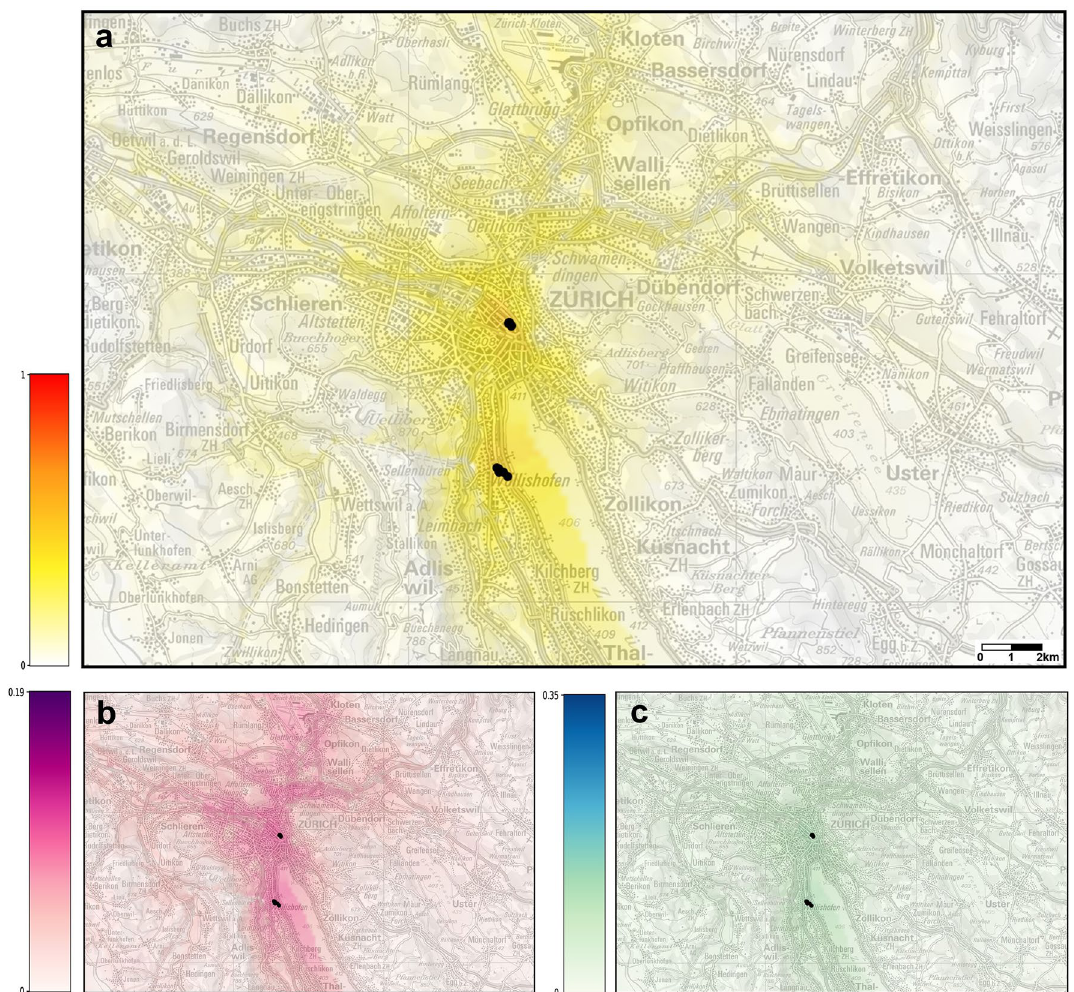
Figure 7. ( a ) Probabilities of establishment of Ae. albopictus in Zurich using the temperatures corrected with the microclimatic model. The map shows the average risk estimate over the years 2015–2018. The color gradient shows the probability of establishment from 0 (white) to 1 (red). ( b ) Uncertainty of prediction (higher values representing more uncertain predictions). ( c ) The difference between the risk estimates obtained using the original temperatures and the transformed ones. Black dots: ovitraps with observation of Ae. albopictus in 2019. Maps modified from https:// map. geoad min. ch/ (accessed on 1 April